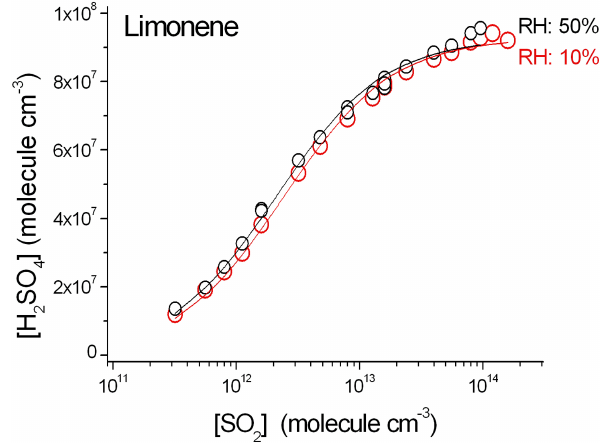
Figure 2. Loss-corrected measured [H 2 SO 4 ] at the outflow of IfT-LFT in limonene ozonolysis experiment at RH = 10% and RH = 50%. Lines show multivariate least-squares fittings accord- ing to Eq. (3).